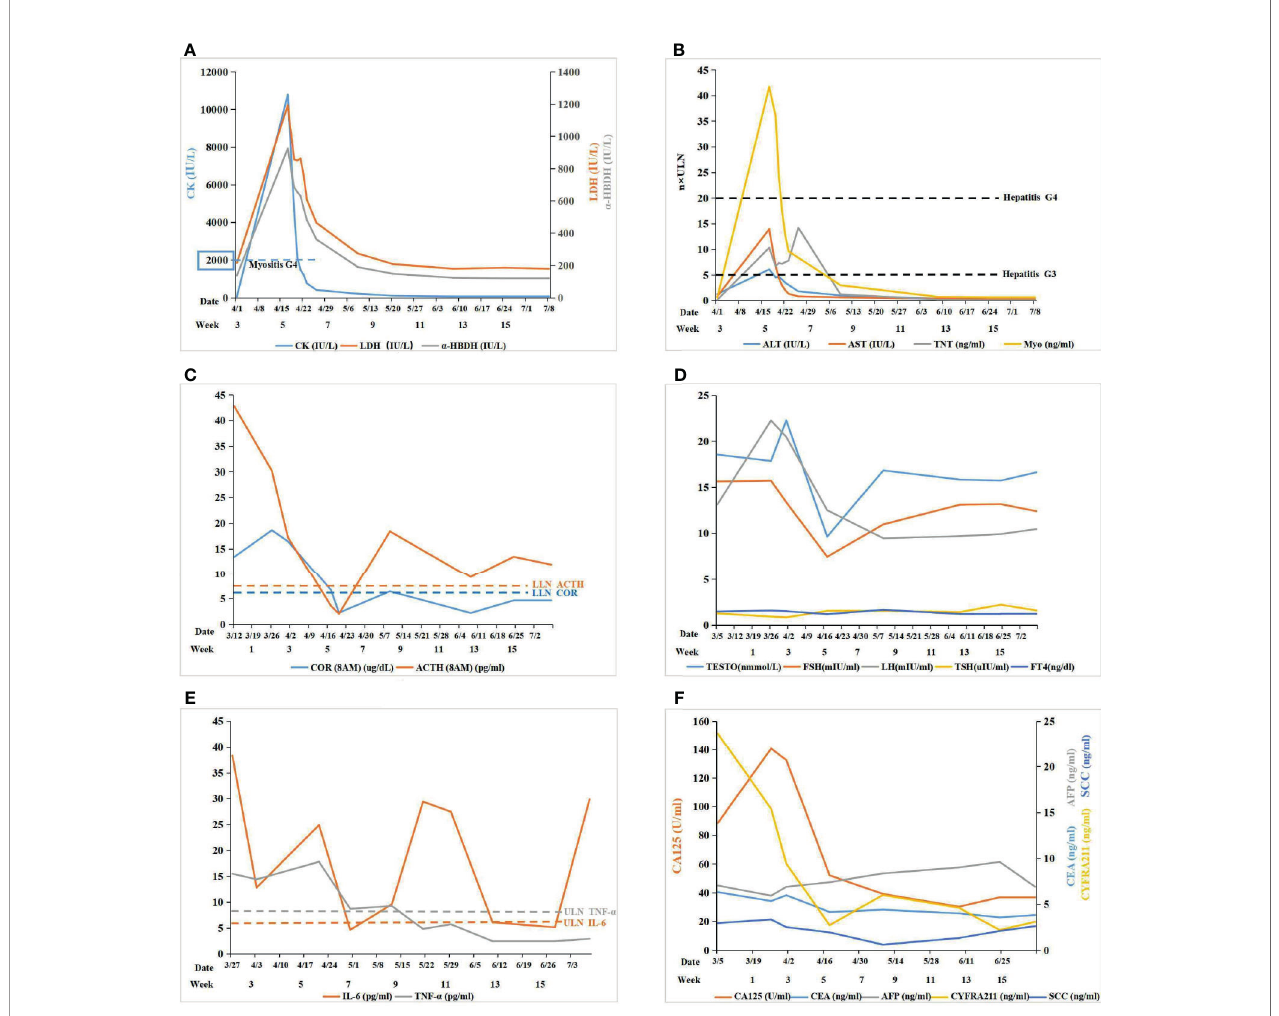
FIGURE 2 | (A) Myositis: the level of serum creatase was used to monitor immune related myositis after immunotherapy; (B) Myocarditis+ Hepatitis: cardiac markers and hepatic transaminase were used to monitor myocarditis and hepatitis, respectively, after immunotherapy; (C) Pituitary-Adrenal Axis: the level of COR and ACTH were used to monitor the function of the pituitary-adrenal axis: COR and ACTH both declined remarkably after ICI therapy; ACTH was maintained at a low level while COR was still lower than the normal value by glucocorticoid replacement therapy; (D) Pituitary-Gonad Axis: the level of FSH, LH, and TESTO were used to monitor the function of the pituitary-gonad axis: all of them fl uctuated in the range of normal values; TSH and FT4 were both normal in the pituitary-thyroid axis; (E) Autoimmune Reponse: IL-6 and TNF- a was used to monitor the autoimmune response induce by ICI: IL-6 fl uctuated beyond the upper limit of normal (ULN) while TNF- a fell to normal gradually after glucocorticoid replacement therapy; (F) Tumor Marker: tumor markers was used to monitor ef fi cacy of